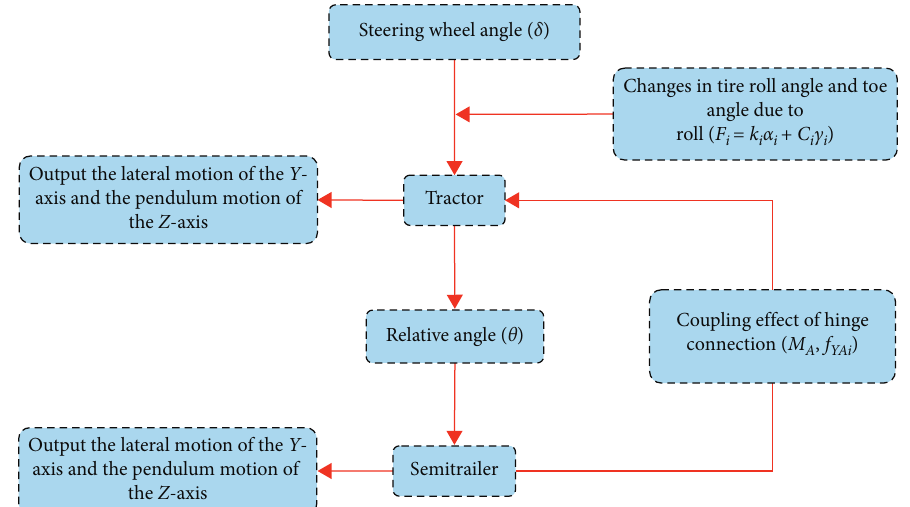
Figure 1: Schematic diagram of the modelling camber angle under the same lateral force are introduced into the model parameter as the influence factor, as shown in Figure 2. The force analysis in Figure 2 is based on Newton’s